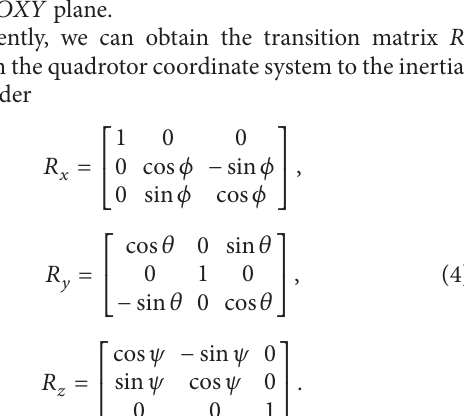
Pitch angle 𝜃 : angle between the 𝑍 -axis and the projection of 𝑂𝑧 in the 𝑂𝑋𝑌 plane. Yaw angle 𝜑 : angle between the 𝑋 -axis and the projection of 𝑂𝑥 in the 𝑂𝑋𝑌 plane. Roll angle 𝜓 : angle between the 𝑌 -axis and the projection of 𝑂𝑦 in the 𝑂𝑋𝑌